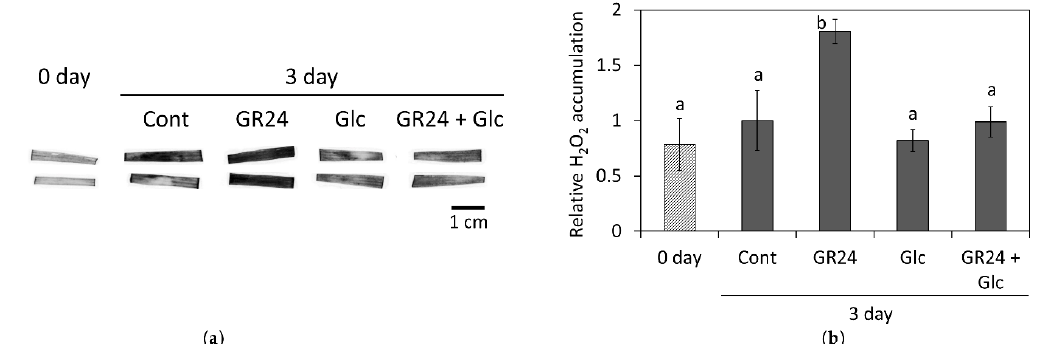
Figure 4. Diaminobenzidine staining to detect hydrogen peroxide (H 2 O 2 ). Leaf segments were treated with 1 µM GR24 and 1% Glc at 25 °C in dark for 3 days. The control (Cont) was treated without GR24 and Glc. ( a ) Visualization of H 2 O 2 accumulation in the leaf segments. Dark pigment indicates the presence of H 2 O 2 . The scale bar represents 1 cm. ( b ) Relative H 2 O 2 accumulation was quantified. Values and bars represent means ± SD of five biological replicates. Letters indicate a significant difference p < 0.05) as determined by Tukey’s HSD test.